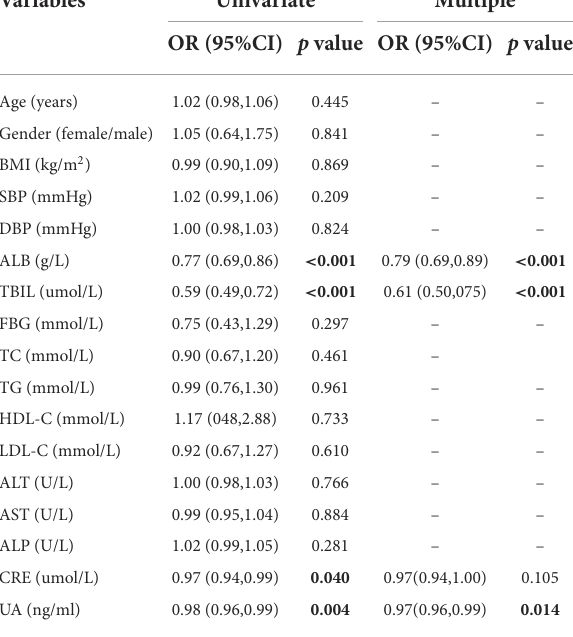
TABLE 3 Univariate and multiple logistic regression analyses to identify the predictors of migraine. Variables